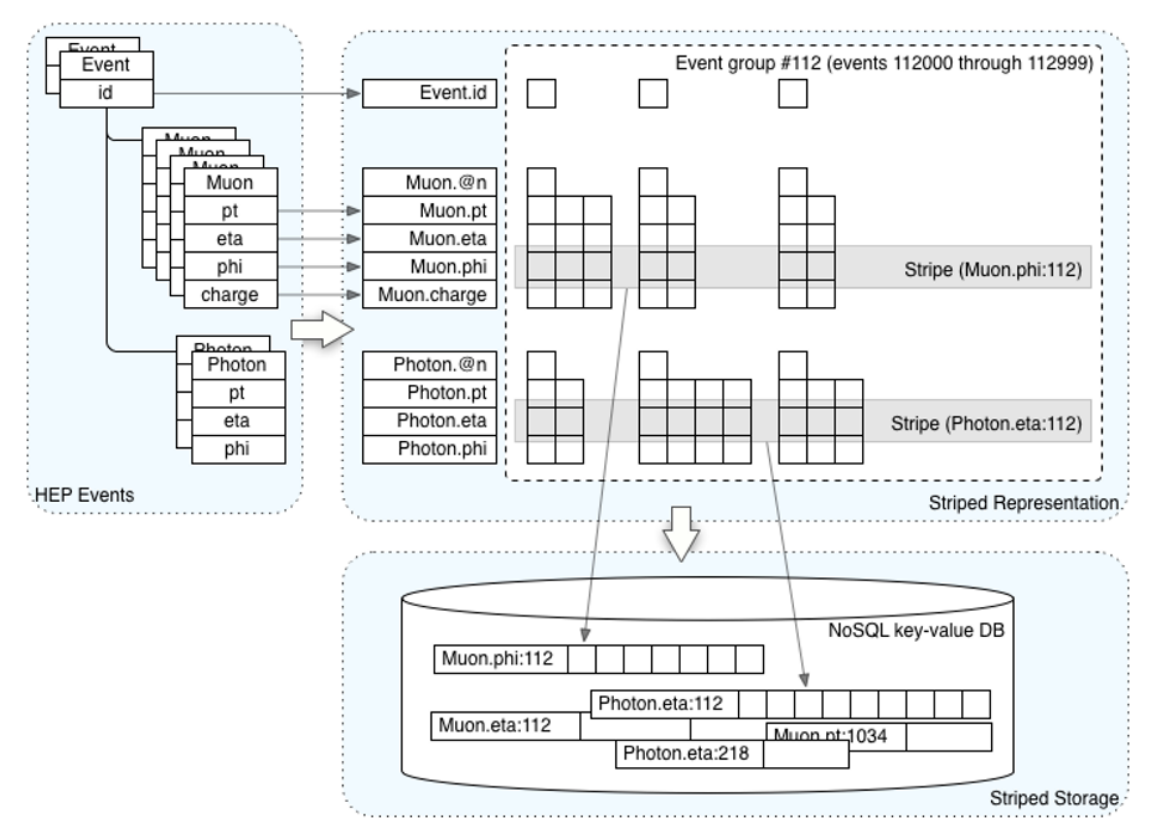
Figure 2. Striped Data